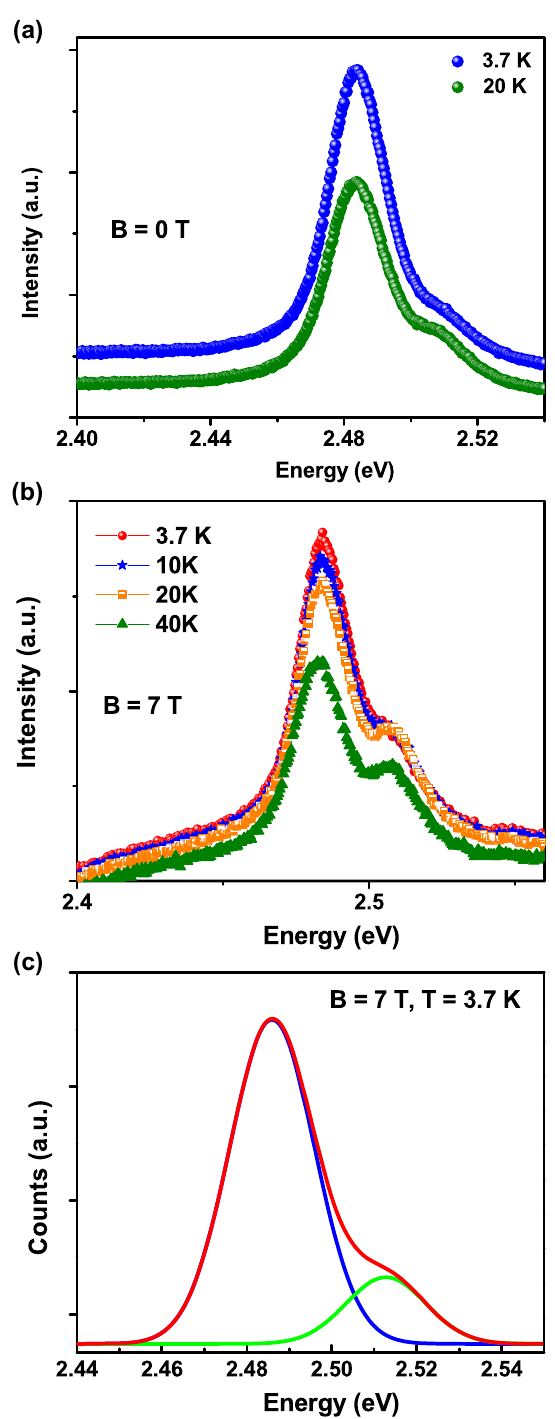
Figure 3: Temperature effect on PL properties with and without magnetic field. (a) Low-temperature PL study of Cu-doped CdSe NPLs at different lower temperatures without magnetic field ( B = 0 T). (b) Temperature dependence of excitonic features at 3.7 K (red), 10 K (blue), 20 K (orange), and 40 (green) with applying magnetic field ( B = 7 T), (c) the magneto-PL fitting in the vicinity of excitonic emissions. Bands in green and blue are recognized as free-exciton and bound-exciton emissions,